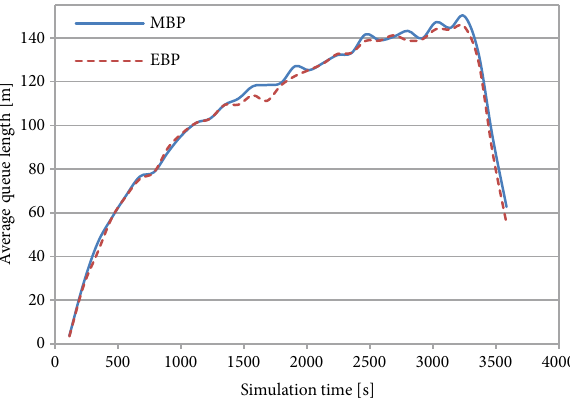
Figure 5. Average queue length of traffic network under different control algorithm